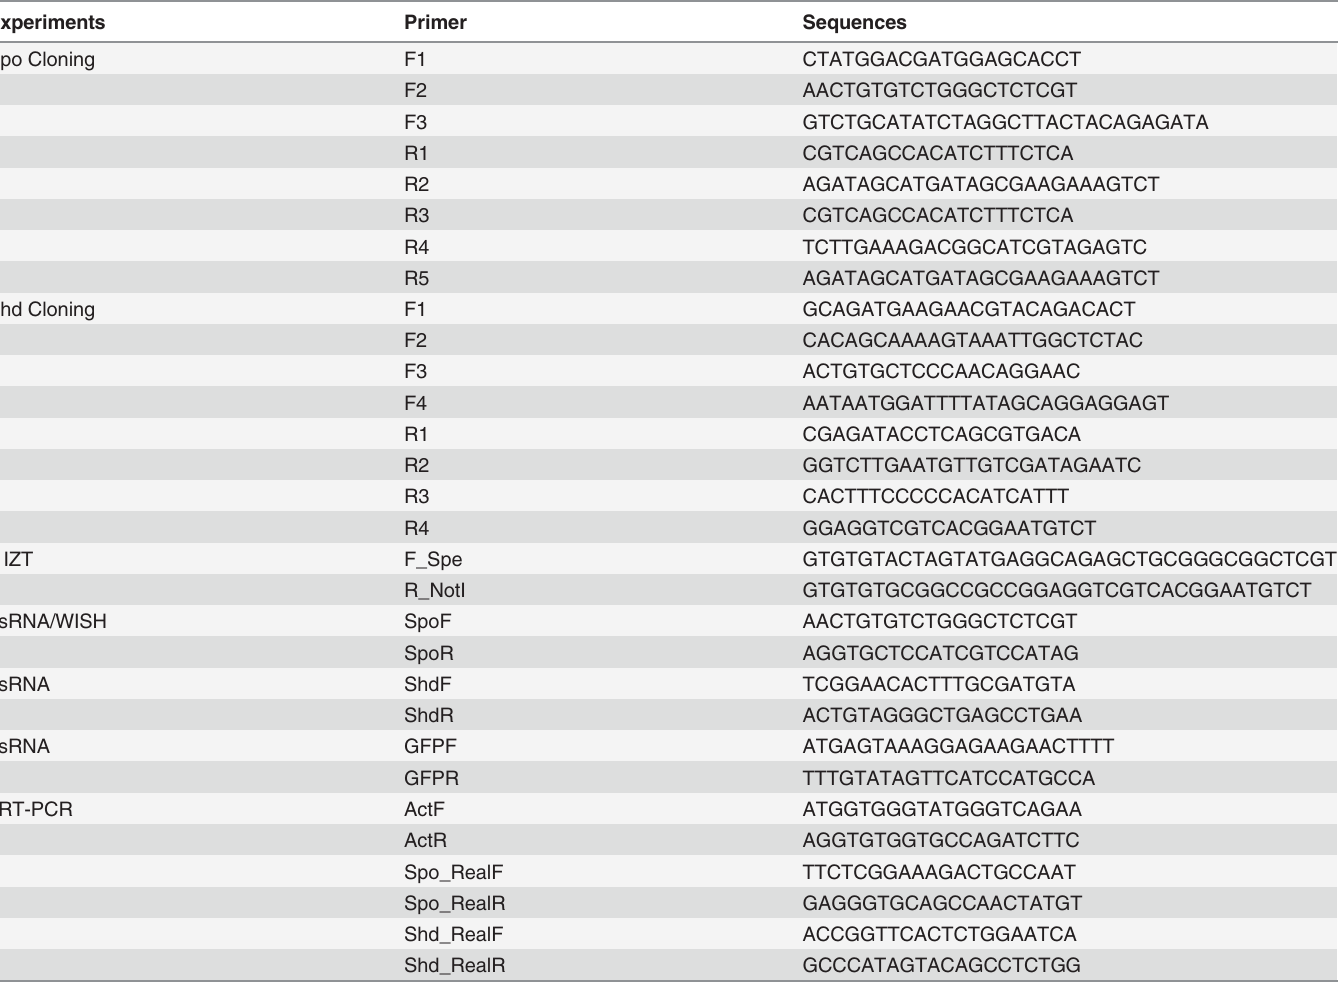
Table 1. Primers used in this